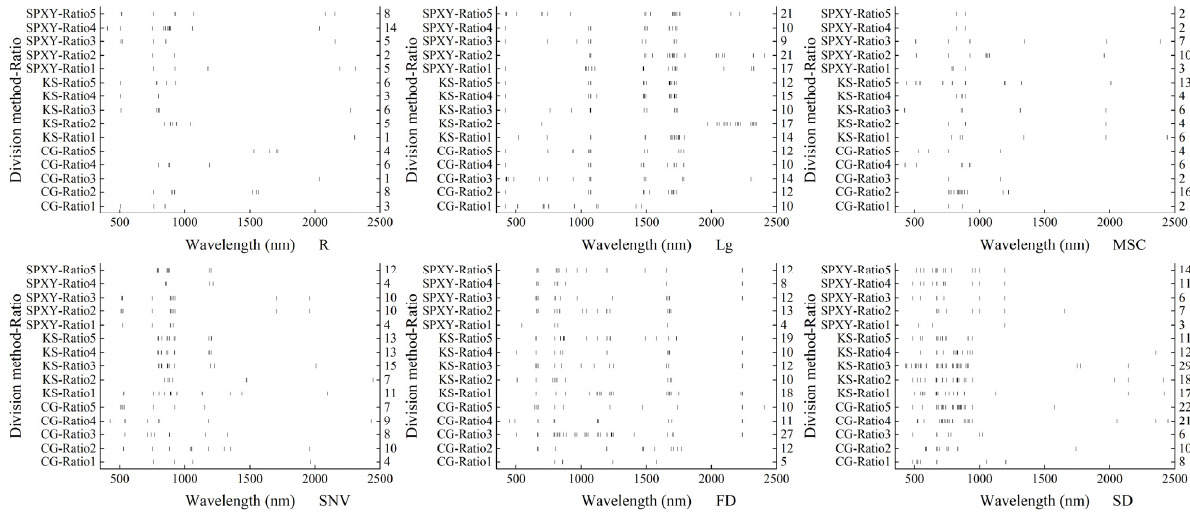
Figure 7. SMLR modeling bands based on UVE bands.